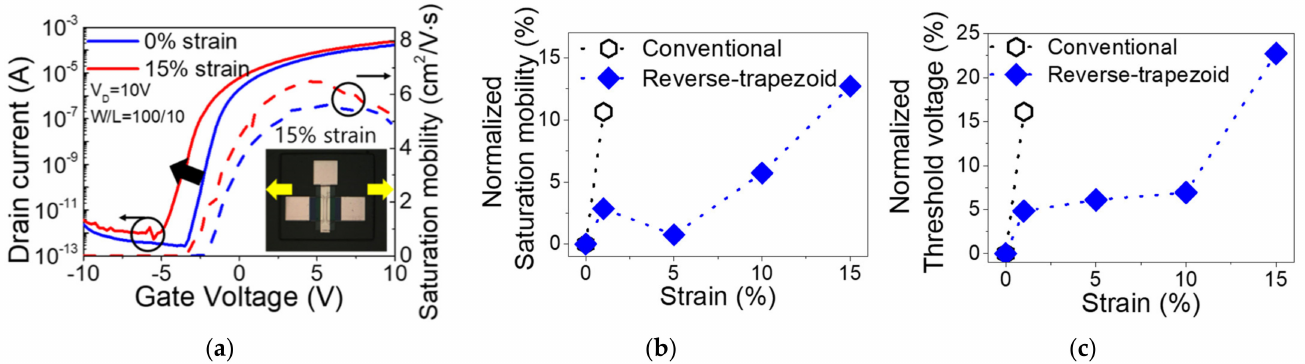
Figure 4. Electrical characteristics of stretchable a -IGZO TFTs on conventional and reverse-trapezoid PDMS. ( a ) Transfer characteristics of stretchable a -IGZO TFTs under a 15% strain. Variation of normalized ( b ) saturation mobility and ( c ) threshold voltage of stretchable a -IGZO TFTs on a conventional and a reverse-trapezoid PDMS as a function of